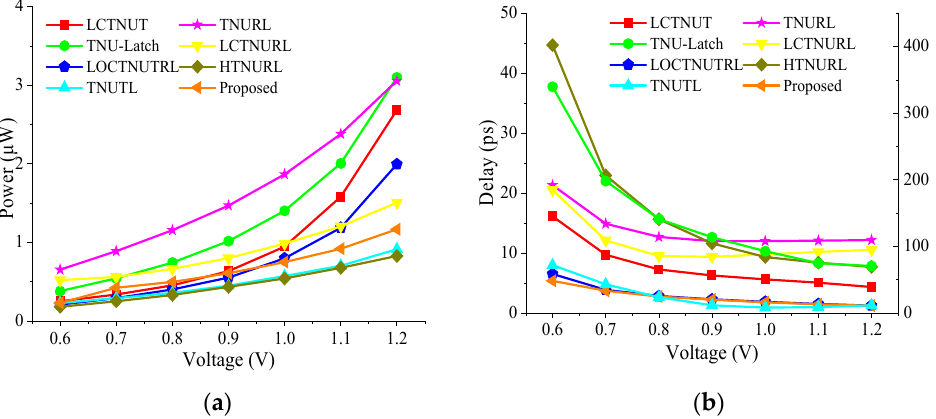
Figure 14. Voltage variations effect on the latches’ performances: ( a ) supply voltage vs. power; ( b ) supply voltage vs. delay.